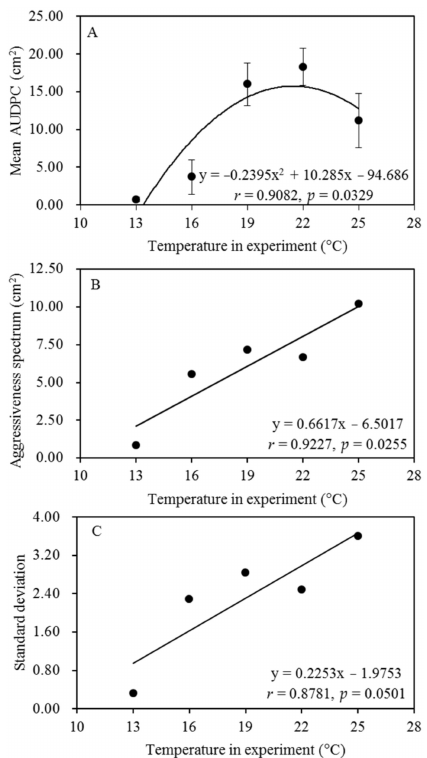
Figure 3. The thermal adaptation pattern of Phytophthora infestans aggressiveness estimated from 140 isolates sampled from seven geographic locations with different annual mean temperatures: ( A ) the thermal reaction norm estimated from AUDPC of isolates at the five temperature regimes; ( B ) the spectrum estimated from the difference between isolates with the highest and lowest aggres- siveness in the populations; ( C ) standard deviation of aggressiveness of the 140